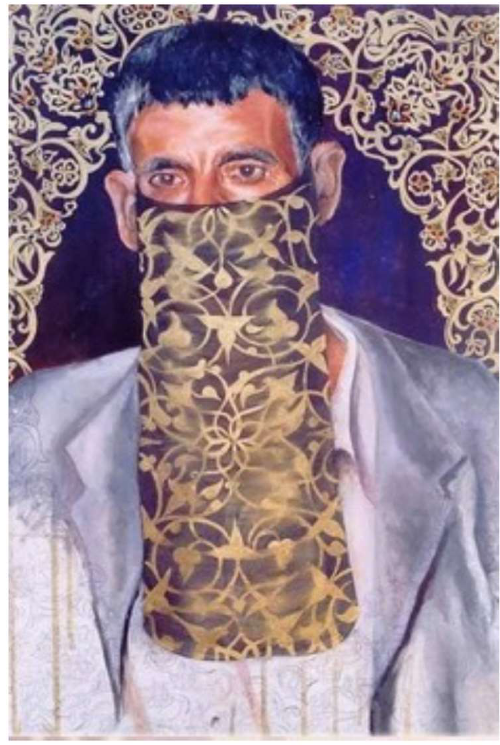
Figure 8. Fatima Abu Rumi, Father , 2005, oil on canvas, 50 on 70 cm.